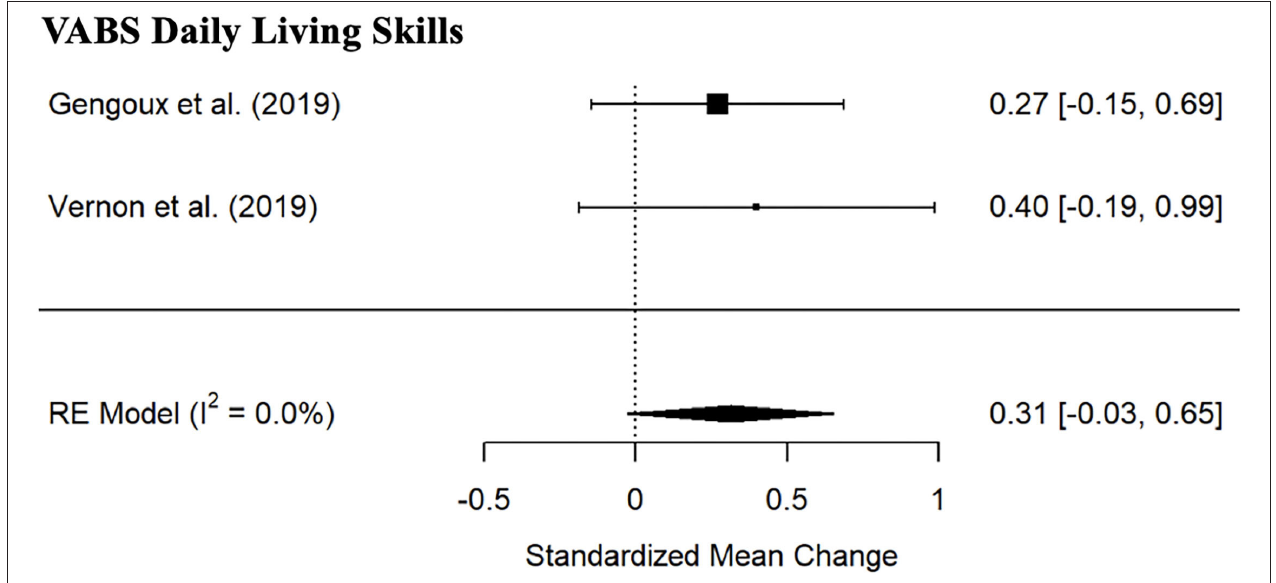
FIGURE 4 | Forest plot of estimates for PRT effects for Vineland Daily Living Standard scores.